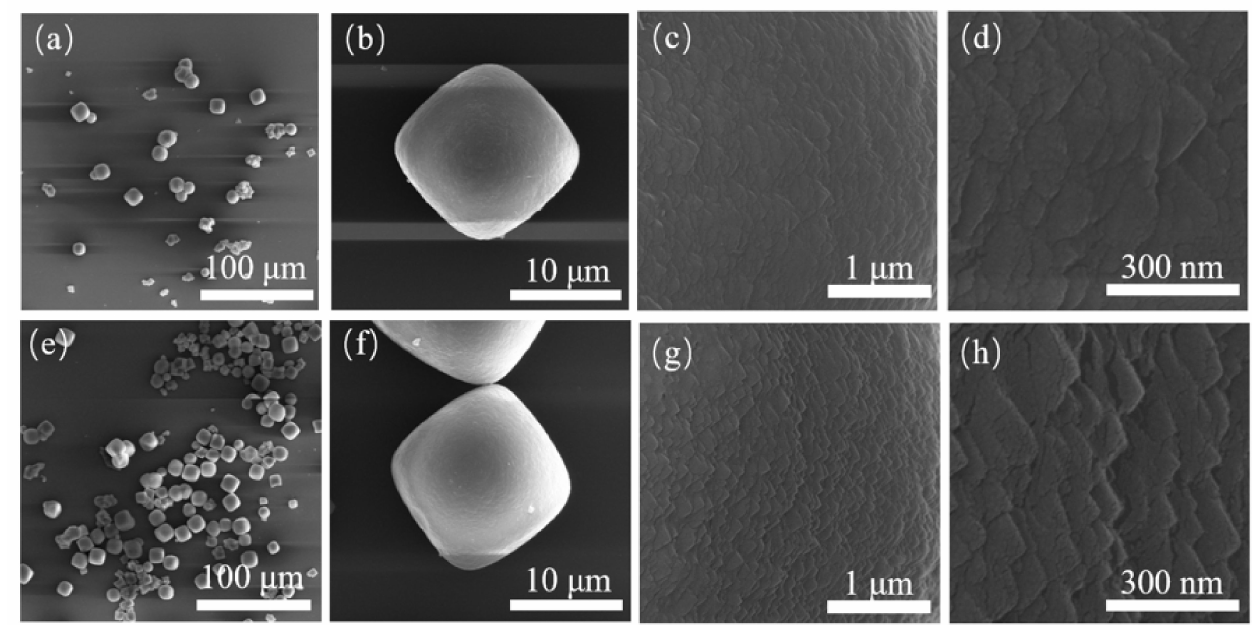
Figure 4. SEM diagrams of S-7 ( a – d ) and S-8 ( e – h ) with different magnifications. The above phenomena indicated that the zeolite grew from spherical crystal to rounded crystal and then to cubic crystal during the assembly of the unit crystal. Re- gardless of the shape of the unit crystal, it participated in the assembly process. The specific crystal growth diagram is shown in Figure 5. With the extension of reaction time, it can be seen from the TEM images of sample S-6 in Figure 6 that there was no obvious pore structure inside the crystal, and there were many staggered crystals on the sample surface. Some cracks appeared in the interlaced part of the sample